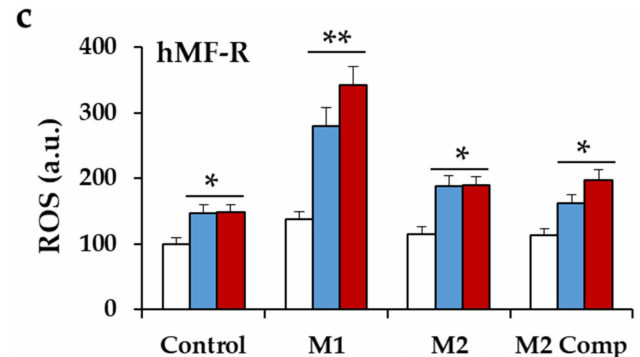
Figure 2. E ff ect of TRB and LUR on the cell cycle distribution, viability and ROS production of polarized hMF-R. ( a ) Cell cycle distribution of hMFs after 24 h treatment with TRB or LUR; ( b ) e ff ect of TRB (5 nM) and LUR (1 nM) on viability; and ( c ) ROS production of polarized hMF-R. M1: lipopolysaccharide (LPS) (100 ng / mL) + interferon- γ (IFN γ ) + interleukin-1 β (IL1 β ) + tumor necrosis factor- α (TNF α ) (20 ng / mL, each); M2: IL4 + IL13 (20 ng / mL, each); M2 Comp: M2 plus IL10 (20 ng / mL). Results show the means + S.E.M. of cells from 8 (panel a) and 12 (panels b, c) di ff erent donors. * p < 0.05; ** p < 0.01; vs. the vehicle (Veh.) condition. a.u.; arbitrary